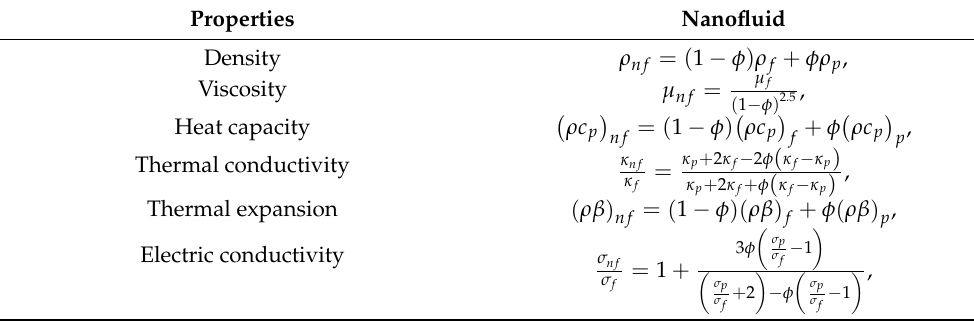
Table 1. Expressions for thermal features of nanofluid Ali et al. [38].